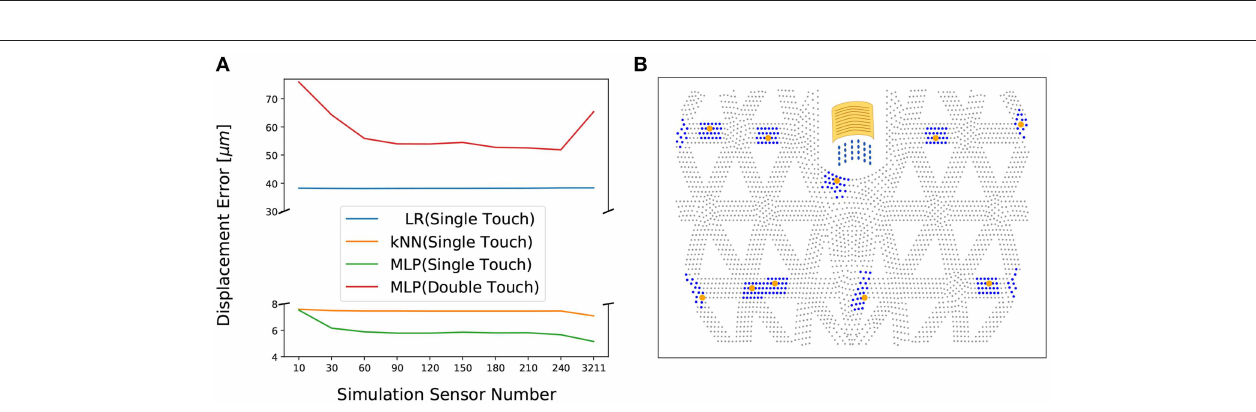
FIGURE 4 | Single-contact information prediction baseline: (A) Prediction accuracy for contact position using SVR, k -NN and FNN. (B) Comparing predictions of SVR, k -NN, and FNN for single-contact force information in a 2D surface projection. Gray dots represent geometry grid, blue dots are ground truth force positions, red, orange and green dots are predicted force positions using SVR, k -NN, FNN, respectively. Arrows indicate the error vectors.